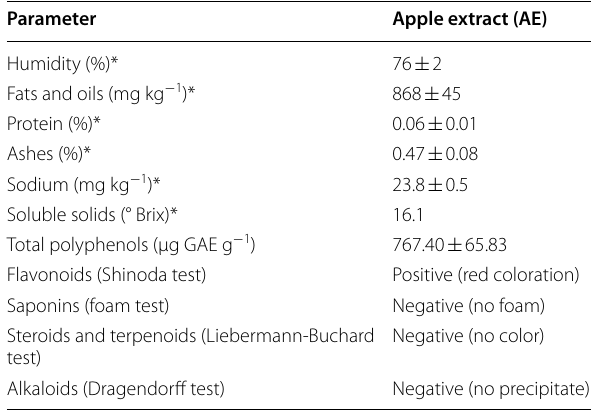
Table 1 General physicochemical composition of the whole